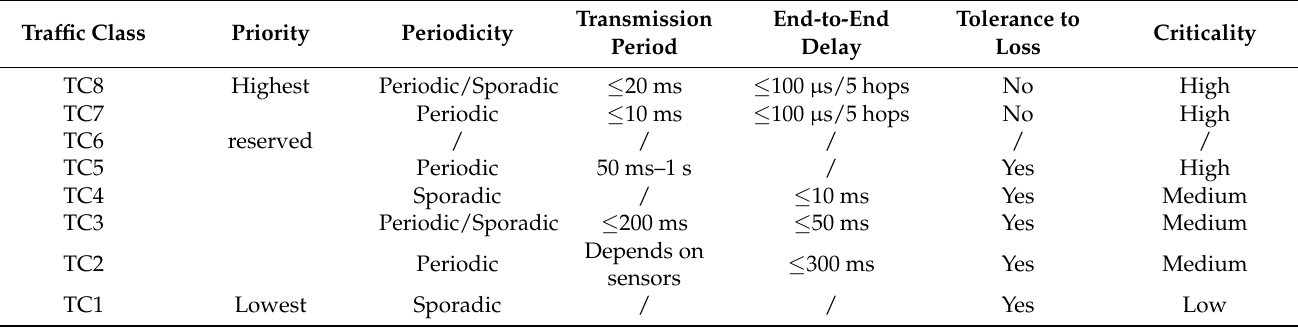
Table 8. Time delay requirements of each traffic